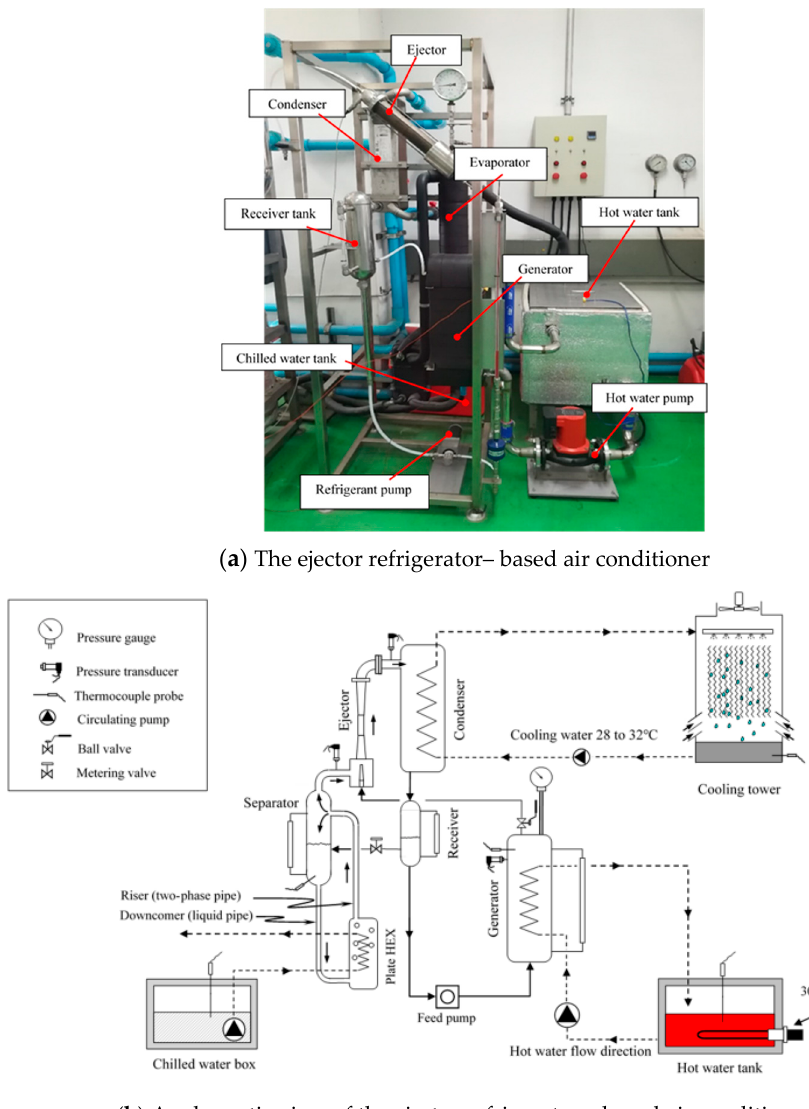
over the plate heat exchanger of 1.2 m to enhance the natural circulation when producing the refrigerating effect. The liquid-vapour separator was made of a 3-inch SUS-304 tube. Its length is 45 cm. Three baffle plates were installed at the upper part to separate the liquid being carried over with vapour.